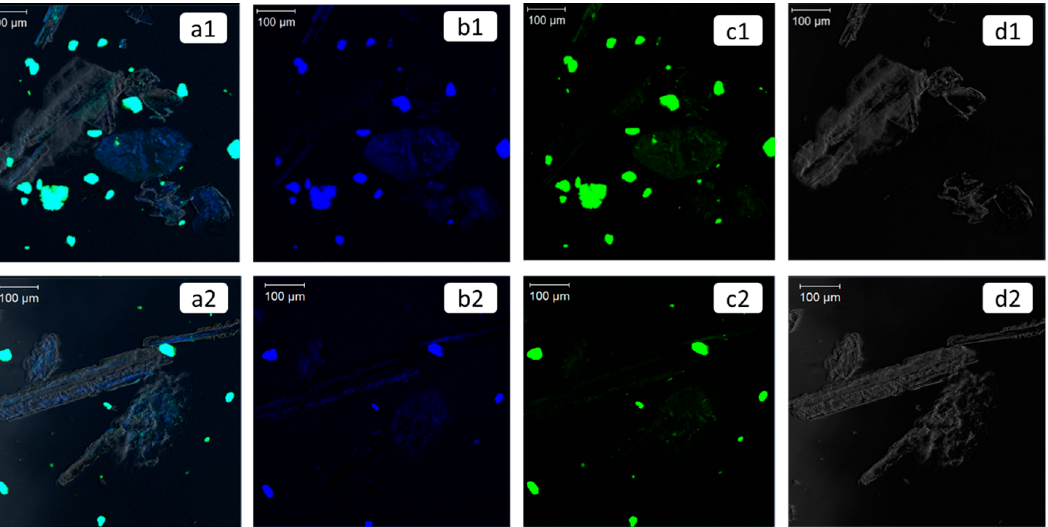
Figure 9. A typical fluorescent image of the liquid phase of a gypsum solution with 10 mg·dm − 3 PAA-F2/HEDP-F blend (1:1 mass) taken at two points (1 and 2) after 24 h thermal treatment (NACE Standard), obtained by a superposition of three channels detection modes ( a1 , a2 ) and with channels decomposition: blue ( b1 , b2 ), green ( c1 , c2 ) and in transmitted laser light—grey ( d1 , d2 ). Scale marker corresponds to 100 µm. Crystals 2020 , 10 , x FOR PEER REVIEW 14 of 16